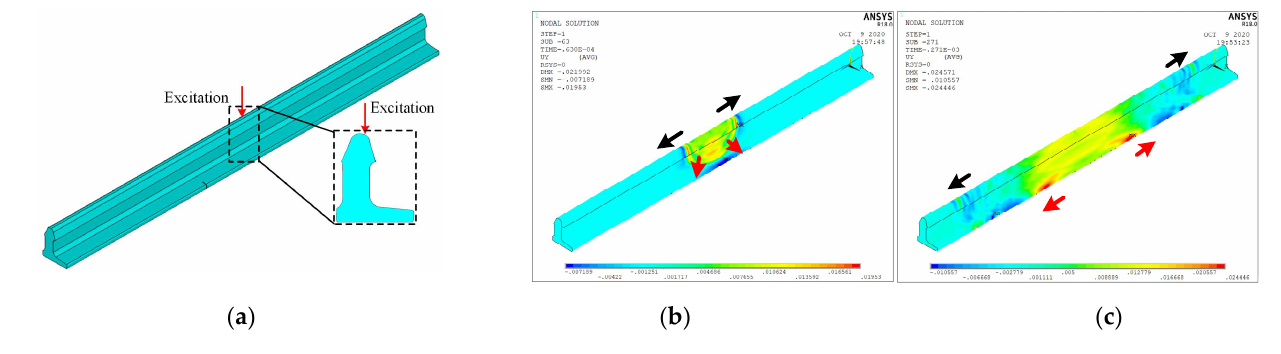
Figure 2. Finite element simulation model and results: ( a – c ). Table 1. The material parameters of simulation model. Young’s Modulus/GPA Poisson’s Ratio Density/kg/m 3